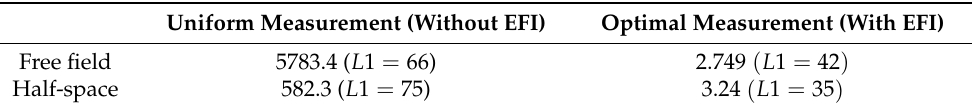
Table 5. Different values of 𝛾 (cid:4593) in vibration reconstruction equivalent source method (VR-ESM) with 90 measurement points. EFI, efficient independence.